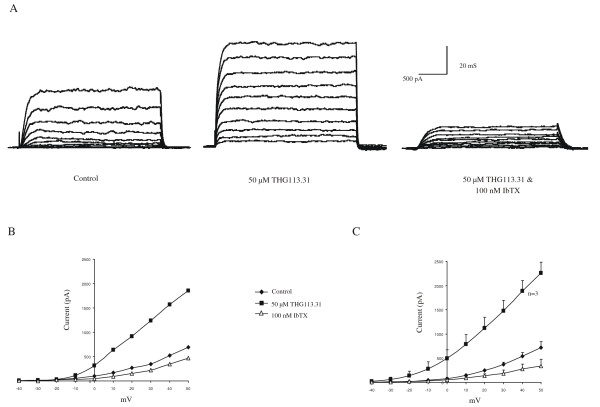
THG113.31 increases whole-cell currents in human uterine smooth muscle myocytes. A Perforated patch recordings (n = 3) from the same myocyte before and 15 min after exposure to 50 μM THG113.31, and then 5–10 min after cumulative addition of 100 nM IbTX. Tracings were taken from a range of potentials (-40 to +50 mV), with a holding potential of -60 mV. B The complete current (pA)-voltage (mV) relationship for steady-state outward current from the same cell as in A. Treatment conditions are the same as described for control, 50 μM THG113.31, and THG113.31 and 100 nM IbTX. C Average current-voltage relationship for uterine myocytes before and after 50 μM THG113.31, and then cumulative addition of 100 nM IbTX. Each point represents the mean number of cells ± SEM.